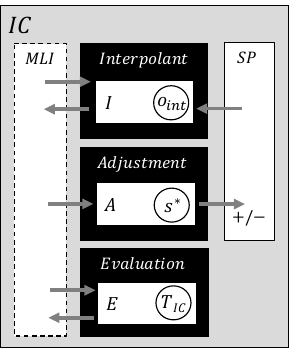
Figure 2. A schematic of the Interpolation Component from Stein et al.